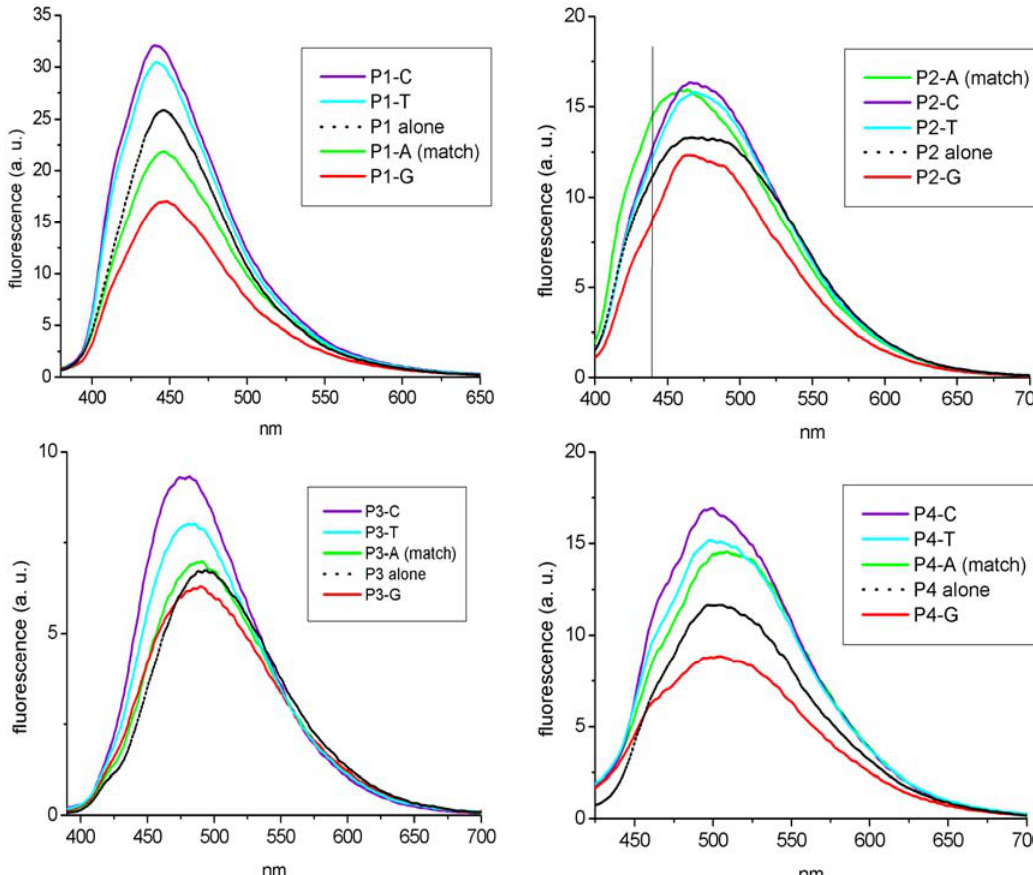
Figure 3. Fluorescence emission of probes P1 to P4 alone (black lines) or after hybridization with target A (green lines), T (cyan lines), C (violet lines) and G (red lines). Generally there is a remarkable difference in the intensity of the emitted light between of the hybrids, depending on the base facing the modified uridines. Sometime as in the case of P2 the differences can be better observed at a wavelength different from that of the maximum of emission f. i. at 440 nm (along the